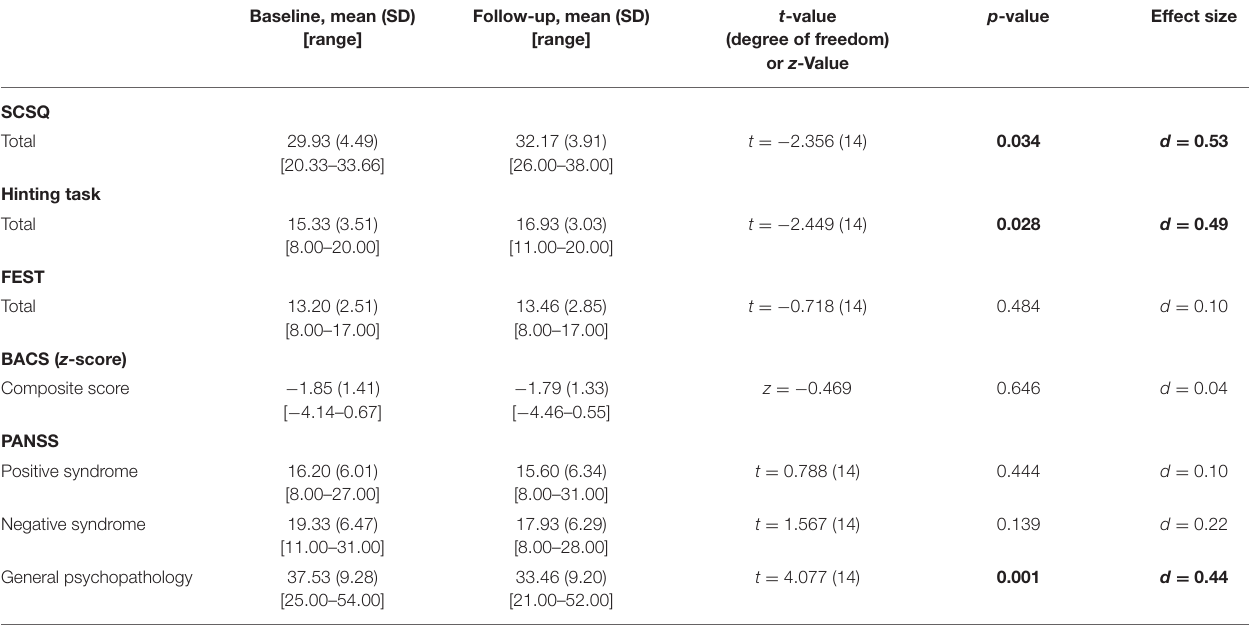
TABLE 5 | Outcome measures at baseline and 1 month after the tDCS.